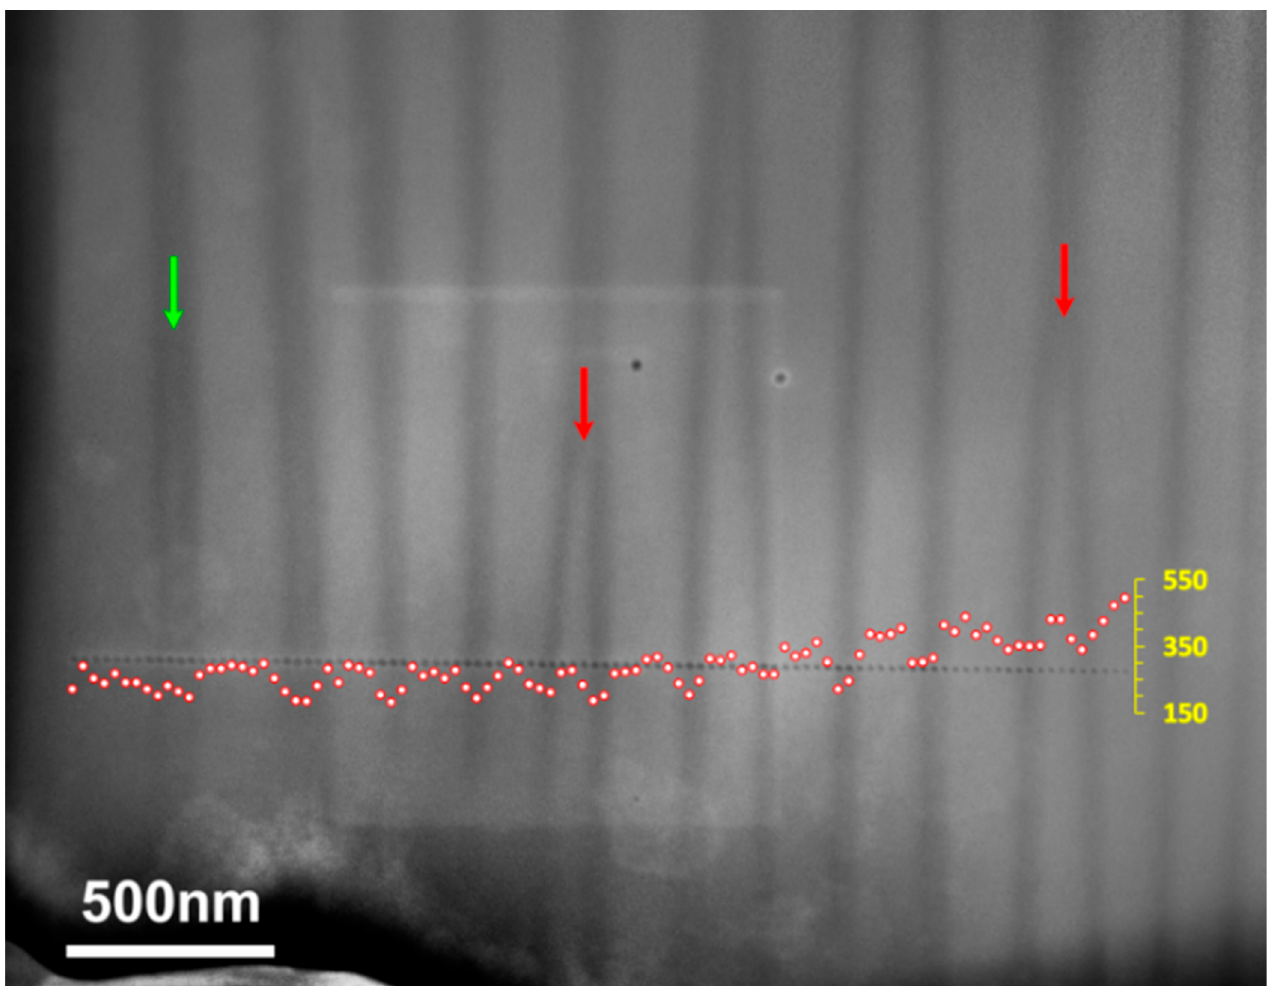
Figure 3. HAADF STEM image of sample 987L. The bright and wider lamellae are Ca-rich and the dark and thinner ones are Na-rich. EDS data are collected on a traverse across the lamellae, which left a straight line of dark dots in the image. High-resolution TEM images of the sample after electron beam damage can be found in Figure S9, which shows that the beam-damaged zones from separate spots sometimes interfere with each other. The Ca counts from the EDS spectrum are also plotted on the image, matching the marks corresponding to each data point. The green arrow marks the center of a wider Na-rich lamellae, which appears slightly more calcic. The two red arrows mark the Ca-rich lamellae wedged into branched Na-rich lamellae.